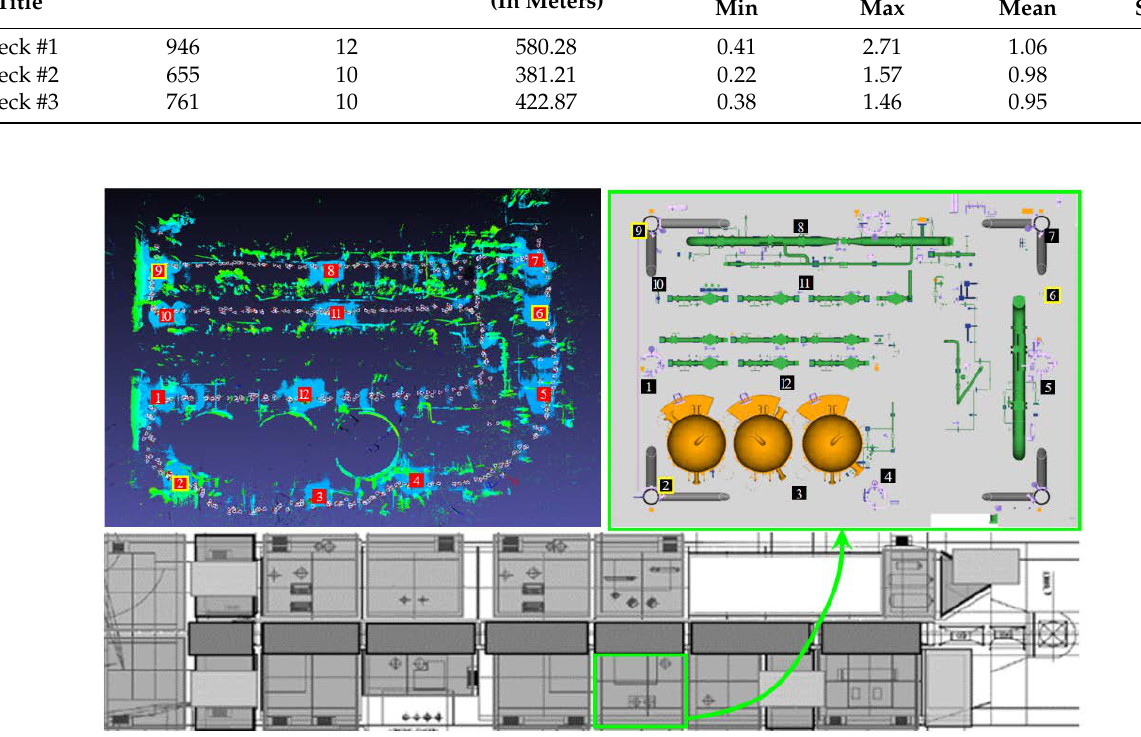
Figure 14. A result of marker registration using the proposed method. Table 1. Accuracy evaluation using re-projection error check.